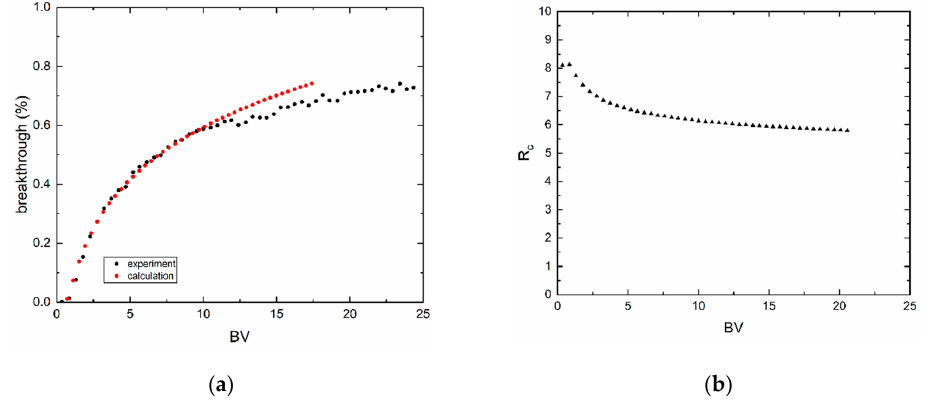
Figure 9. Breakthrough curve of ( a ) BC2a, m = 0.431 g, pH 4, c (NH 4 ReO 4 ) = 10 − 4 mol · dm − 3 , u = 4.5 BV · h − 1 . ( b ) Retardation coe ffi cient ( R c ) as a function of BV. Table 4. The calculated values of sought model parameters and criteria of goodness-of-fit.